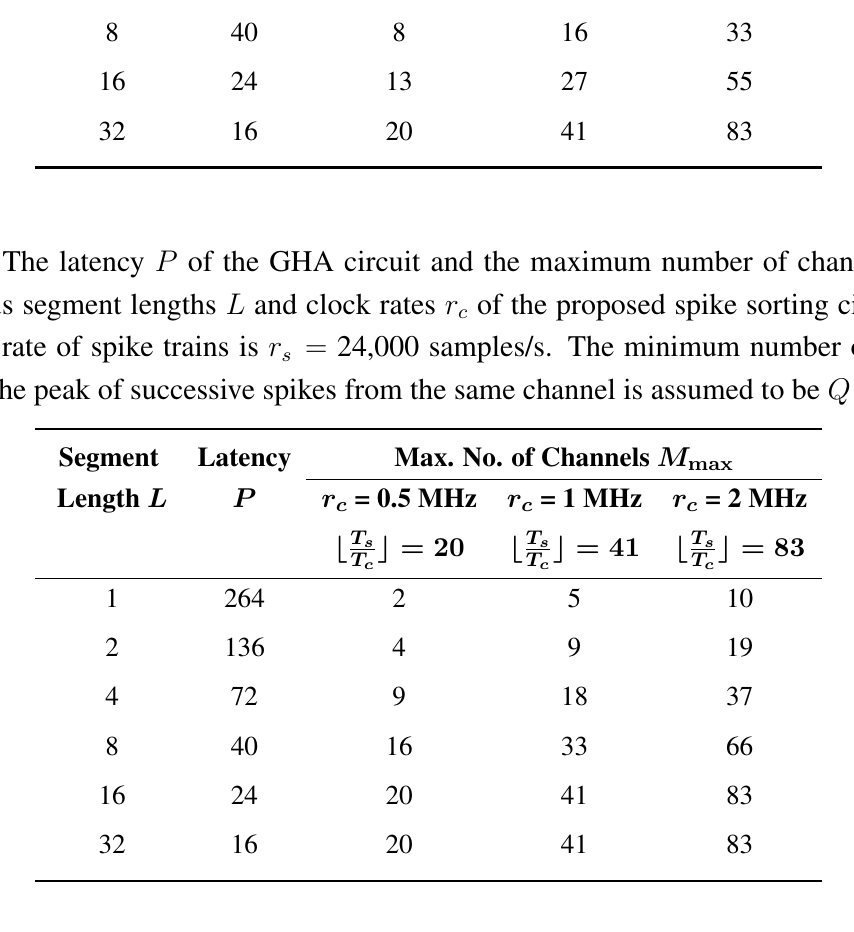
of the proposed spike sorting circuit with clock c = 24,000 samples/s. The minimum number s